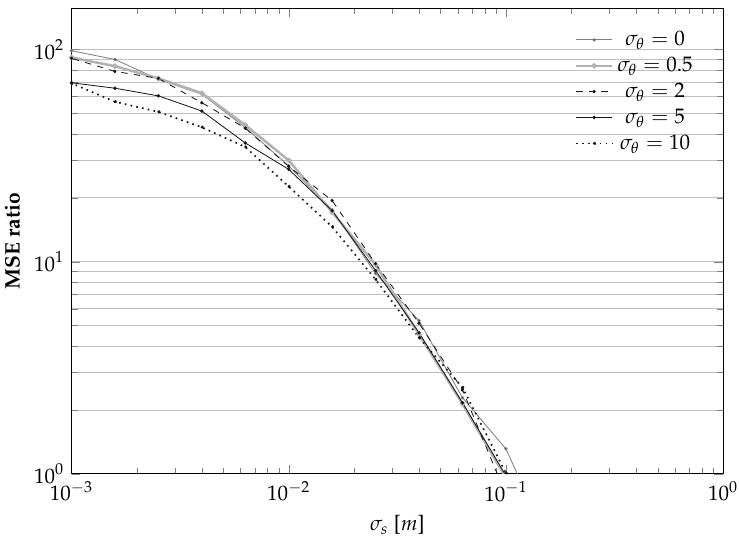
Figure 9. Dependency of the MSE ratio (31) on the standard deviation σ θ of the sensor-to-landmark angle measurement error in (6), and on the standard deviation σ s of the sensor position evolution uncertainty in (8) for the case L = 2.